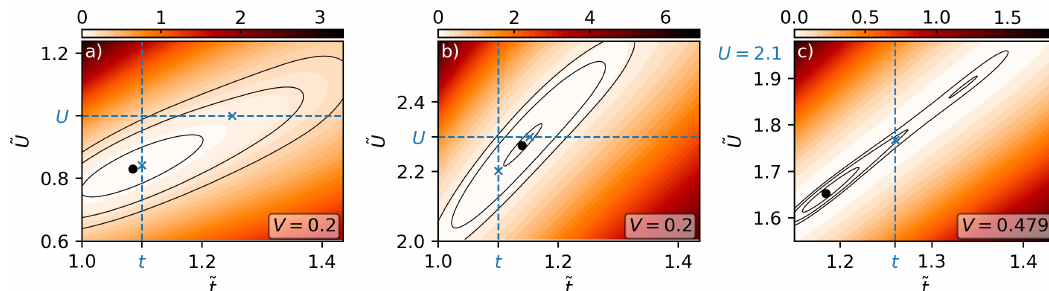
Figure 4: (Color online) Color-coded variational free energy F ν ( ˜ t , ˜ U ) · 10 3 relative to its global minimum for a) a Fermi liquid, b) a strongly correlated regime, and c) at the border between both. The contour lines clarify the low energy structure. Restricted phase space for varying only at fixed ˜ t = t and ˜ U = U and the respective minima are marked as blue dashed lines and crosses respectively. The temperature is T = 0.1.